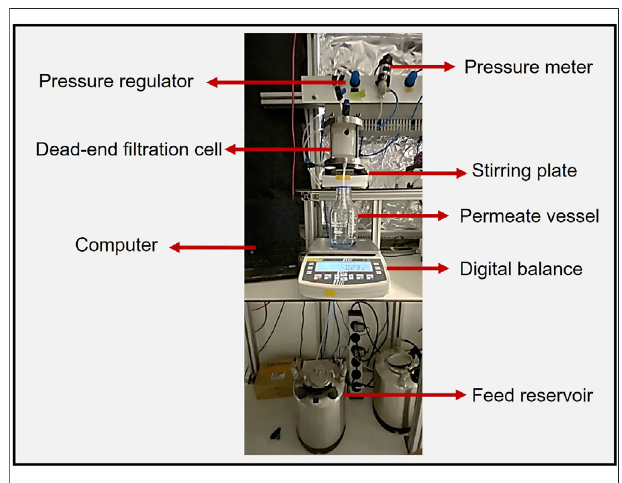
FIGURE 1 | Dead-end fi ltration system used for the sEPS gel layer formation